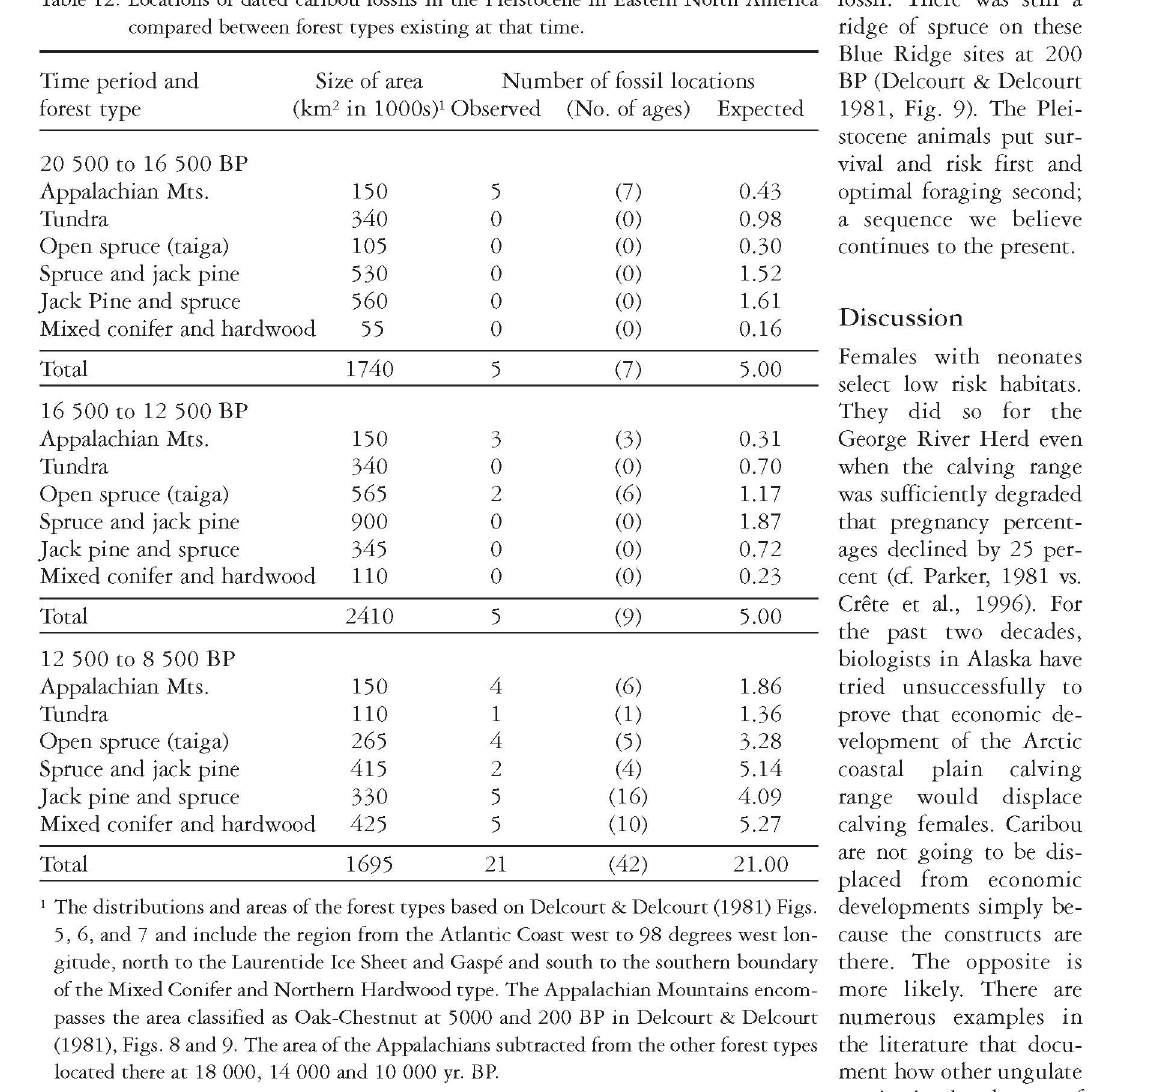
Table 12. Locations of dated caribou fossils in the Pleistocene in Eastern North America compared between forest types existing at that